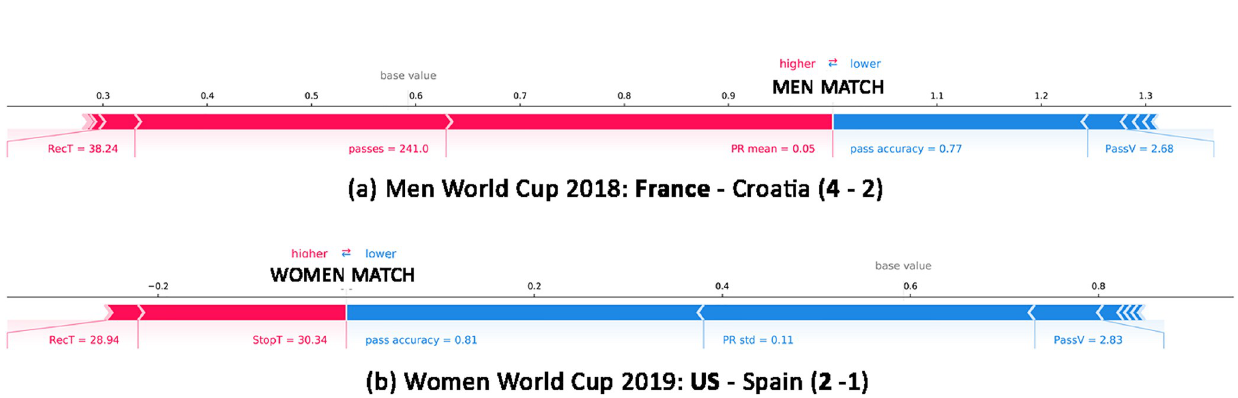
Fig 8. Local Shap explanations for two examples in our dataset: France in France vs Croatia and USA in match USA vs Spain. Feature values that increase the probability of a team to be male are shown in red, those decreasing the probability are in blue.